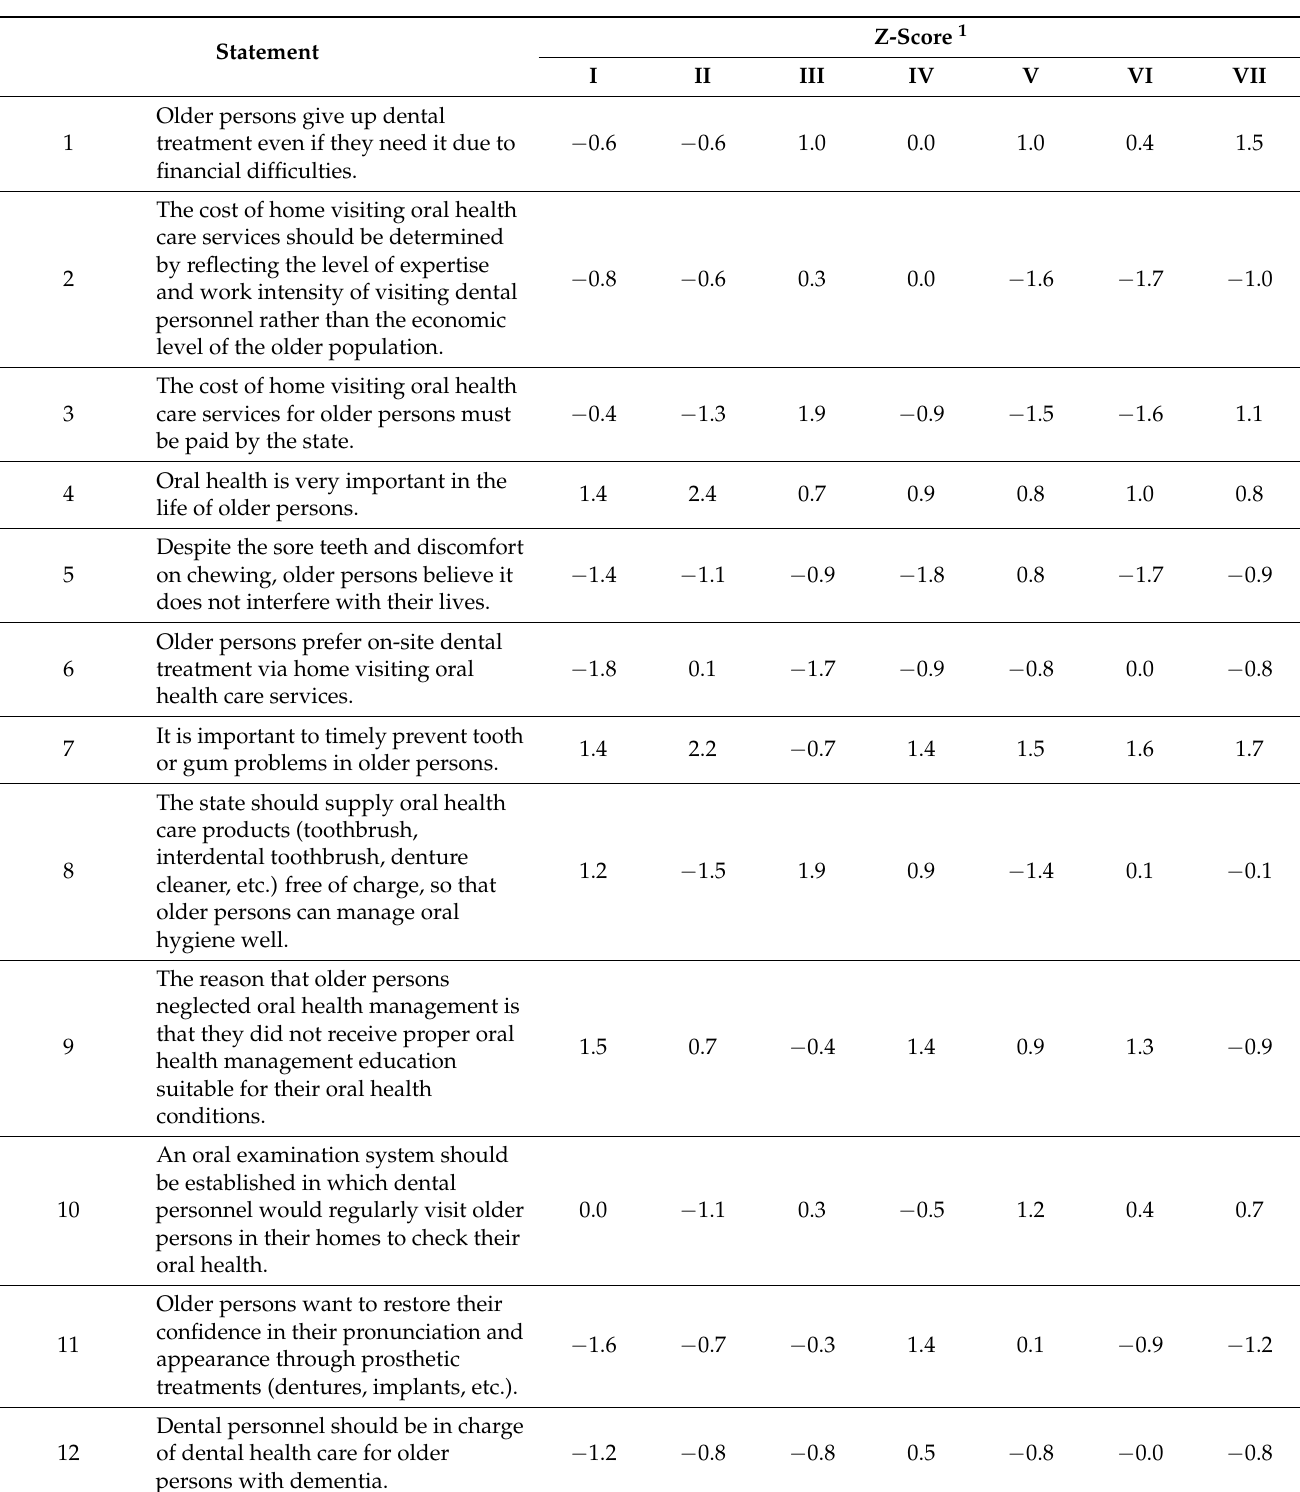
Table 1. Statement rank